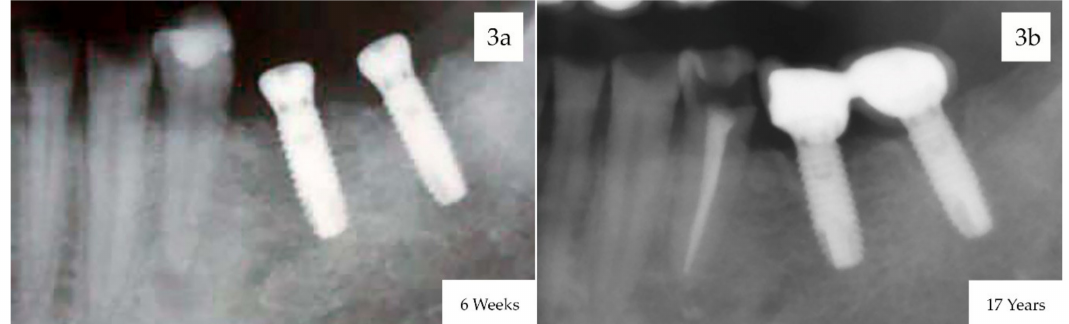
Figure 3. Digital radiographs taken perpendicular to the long axis of the implants used for evaluating marginal bone loss. ( a ) X-rays at 6 weeks after implant placement with the healing abutments ready to start the prosthodontic phase, ( b ) X-rays at 17-years